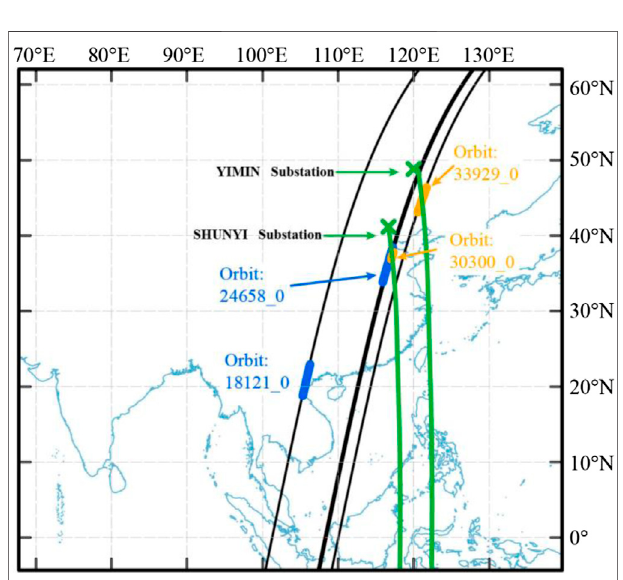
FIGURE 2 | Geographical projections of the satellite orbits with typical PLHR